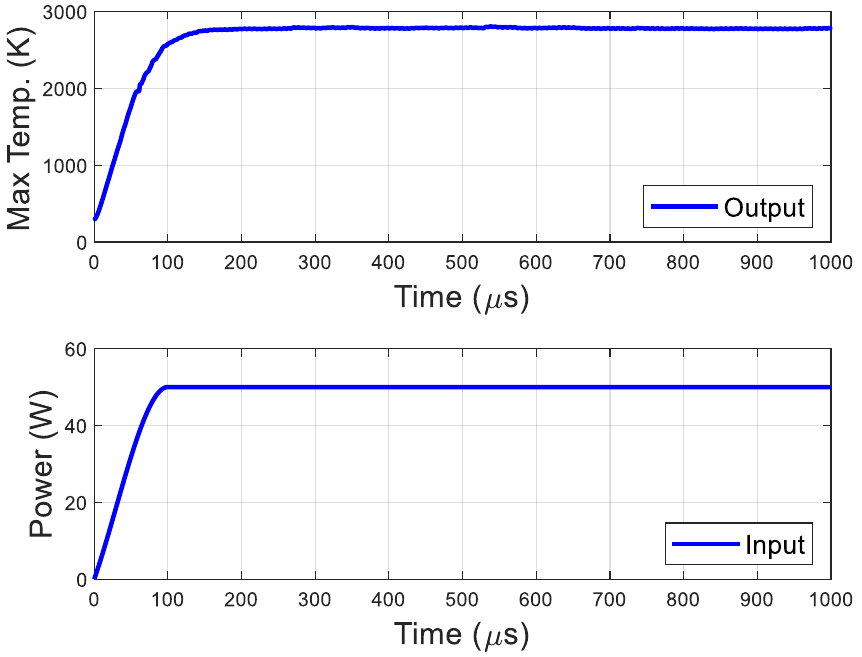
Figure 8. Input-output of FEM for the nominal process.